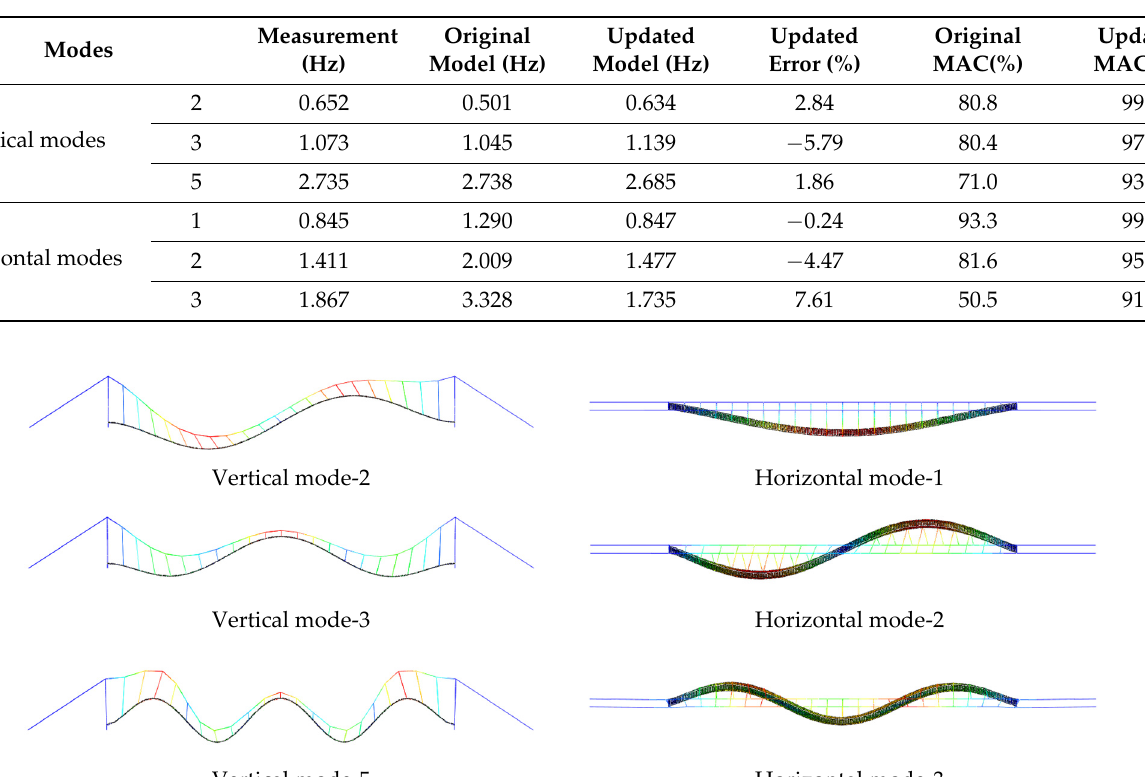
Figure 11. Model update framework with ABAQUS, Python and MATLAB. Table 2. Model updating results to represent the real bridge.